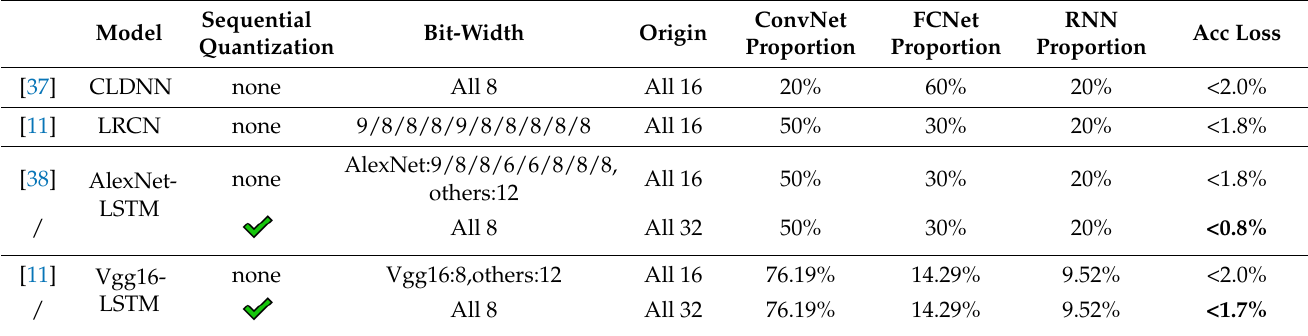
Table 6. Quantization accuracy loss on LSTM-based